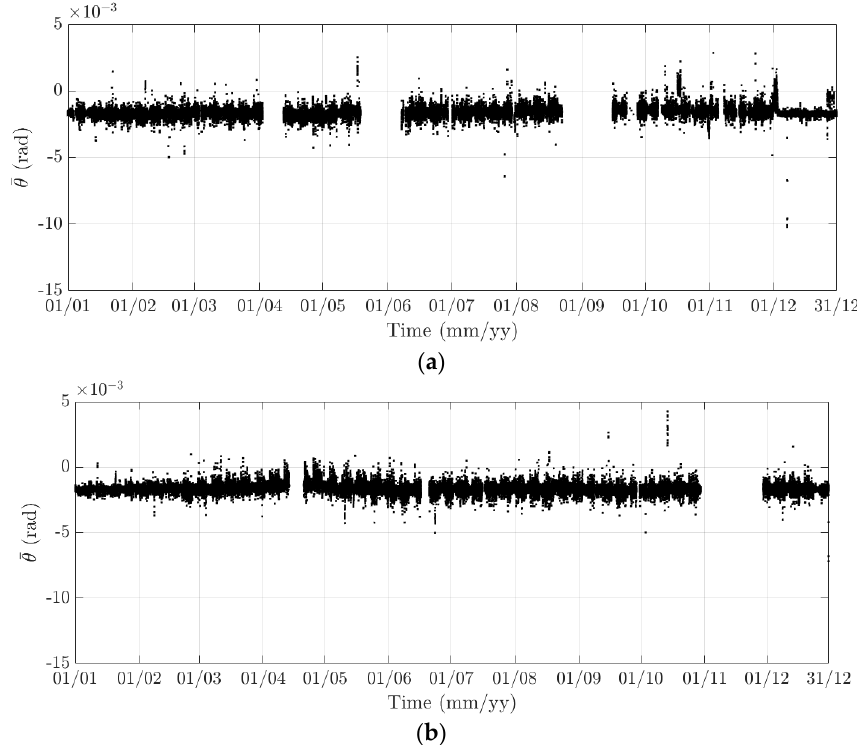
Figure 16. Variation of the 10 ‐ min mean of the torsional response at the mid span of the FRB in ( a ) 2015 and ( b ) 2016.